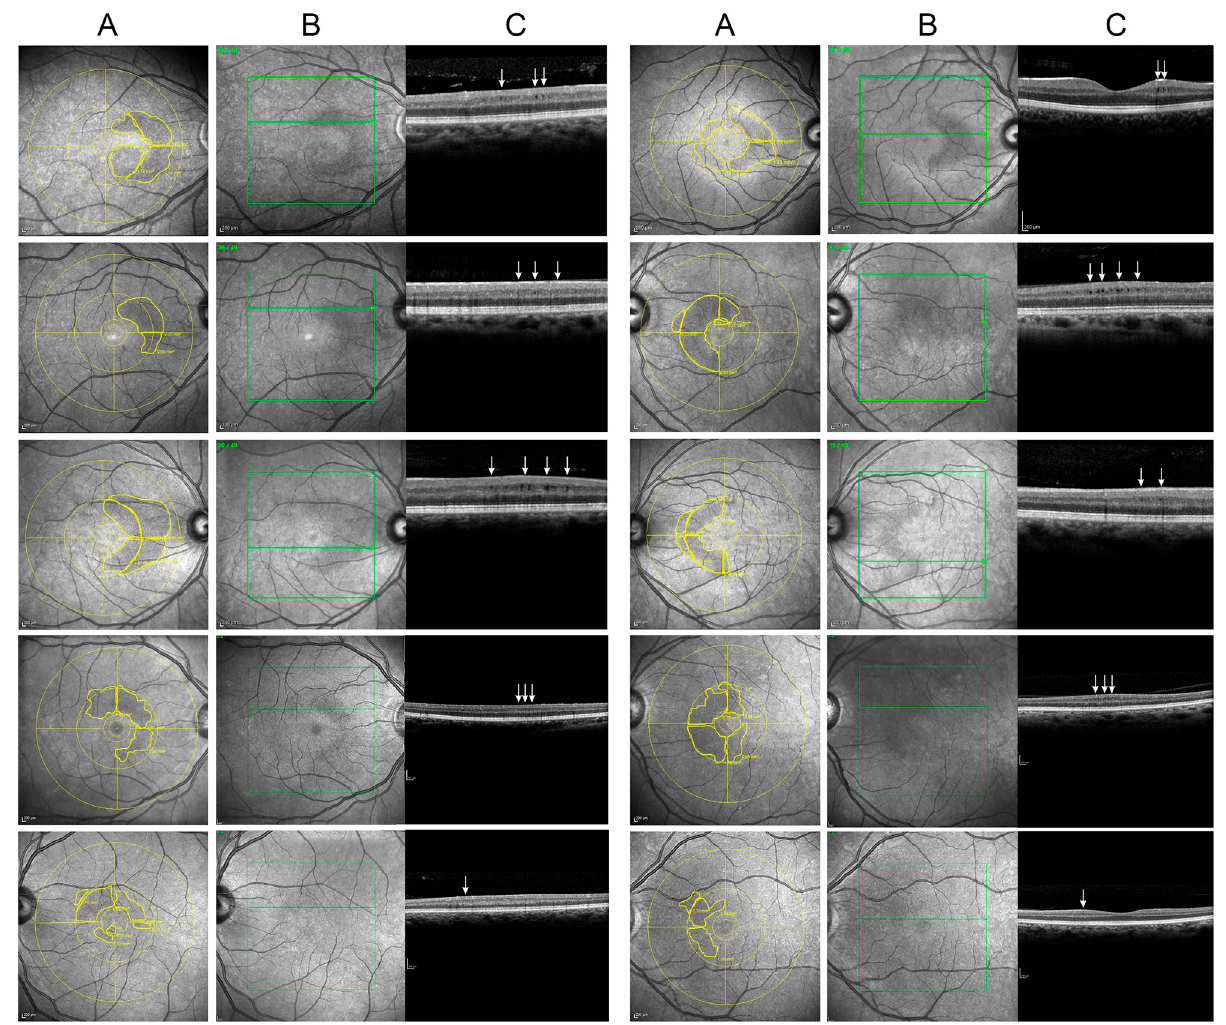
Fig 1. Heildelberg near infra-red reflectance images generated as separate images for the examiners (column A) and as reference images for optical coherence tomography line scans (columm B, not provided to the examiners) and representation of one of the 49 optical line scans submitted to critical evaluation of the presence of microcysts (arrows) in the inner nuclear layer (column